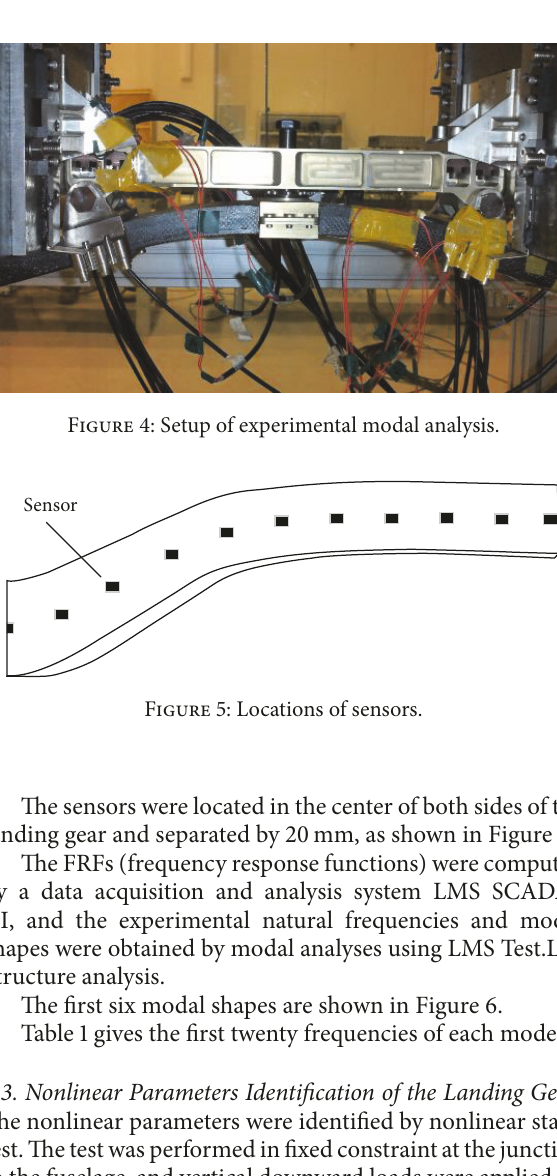
Figure 3: Composition of the landing gear.